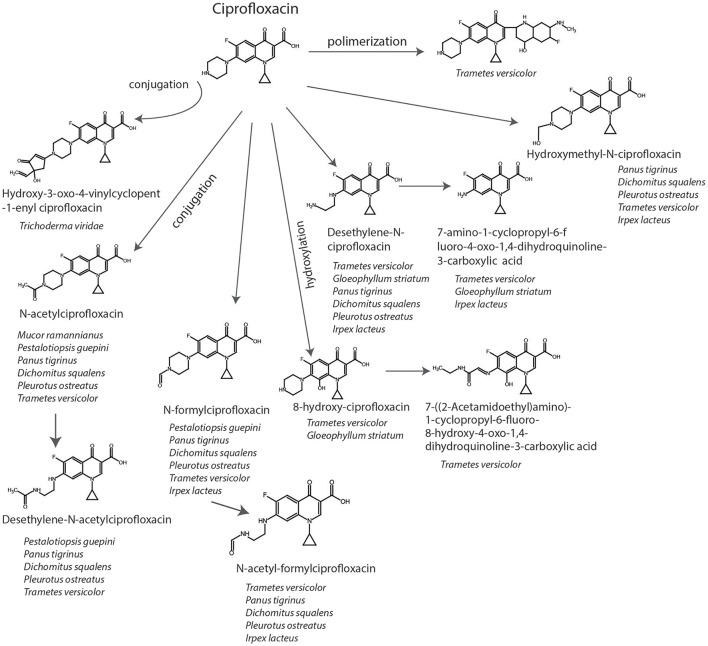
Pathways in the degradation of ciprofloxacin by different phyla of fungi according to Parshikov et al. (2001), Parshikov et al. (2002a), Prieto et al. (2011), and Čvančarová et al. (2015).